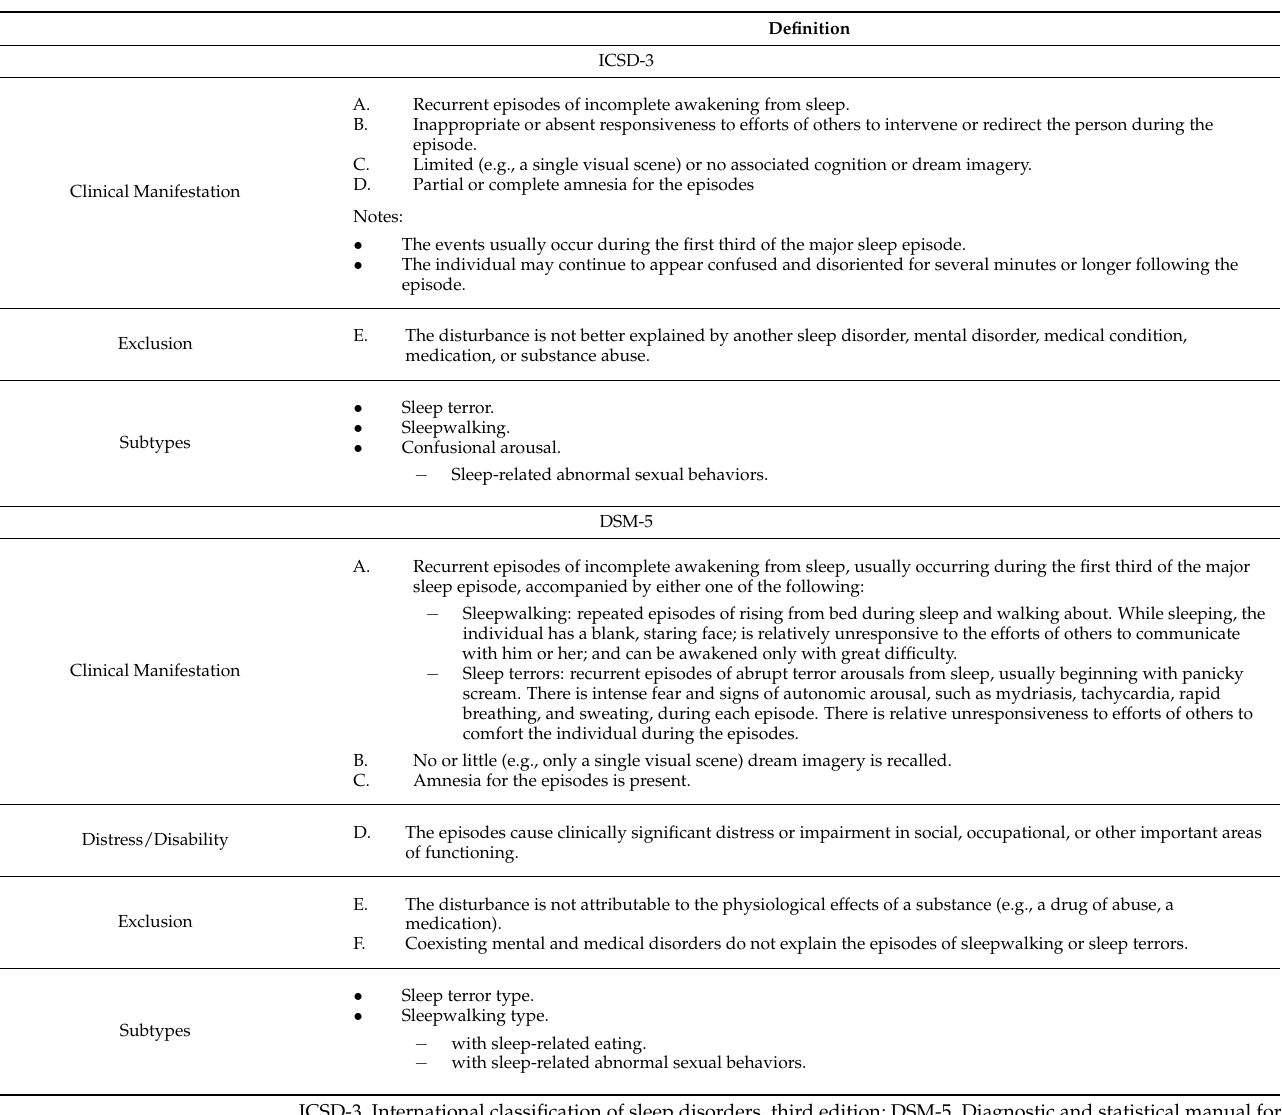
Table 1. International diagnostic criteria for non-rapid eye movement sleep parasomnias according to ICSD-3 and